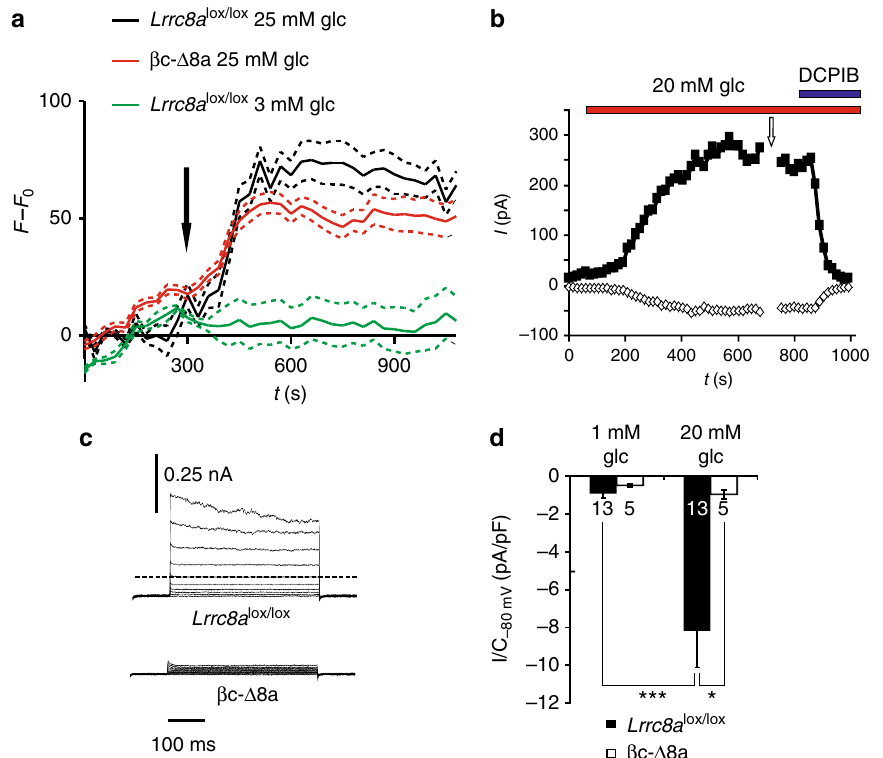
Fig. 3 Cell swelling and induction of LRRC8/VRAC currents in β -cells by high extracellular glucose. a Cell volume as monitored in individual β -cells loaded with calcein. Cell bath was switched from a 3 mM to a 25 mM glucose-containing isotonic solution at the time indicated by the arrow. Shown are mean values ± SEM (dotted lines), n = 15 and n = 23 for Lrrc8a lox/lox and β c- Δ 8a β -cells, respectively, and are representative of three independent experiments. Green trace corresponds to bath change without changing the glucose concentration, a control to exclude perfusion artefacts ( n = 6). b Time course of anion current activation by superfusion with 20 mM glucose in isotonic saline (310 mOsm). Application of 20 µ M DCPIB blocked the currents. Minimal and maximal currents elicited at − 80 or 80 mV by voltage ramps (as in Fig. 2c) are plotted. c Representative current traces obtained after >10 min superfusion with 20 mM glucose from the indicated genotypes. Currents were elicited by the voltage protocol shown in Fig. 2d. The upper traces show currents at the time indicated by the arrow in b . d I Cl,vol current densities at − 80 mV of Lrrc8a lox/lox and β c- Δ 8a β -cells under indicated conditions. Mean currents ± SEM; * p < 0.05; *** p < 0.0005 (one-way ANOVA, Tukey ’ s test); number of cells indicated in